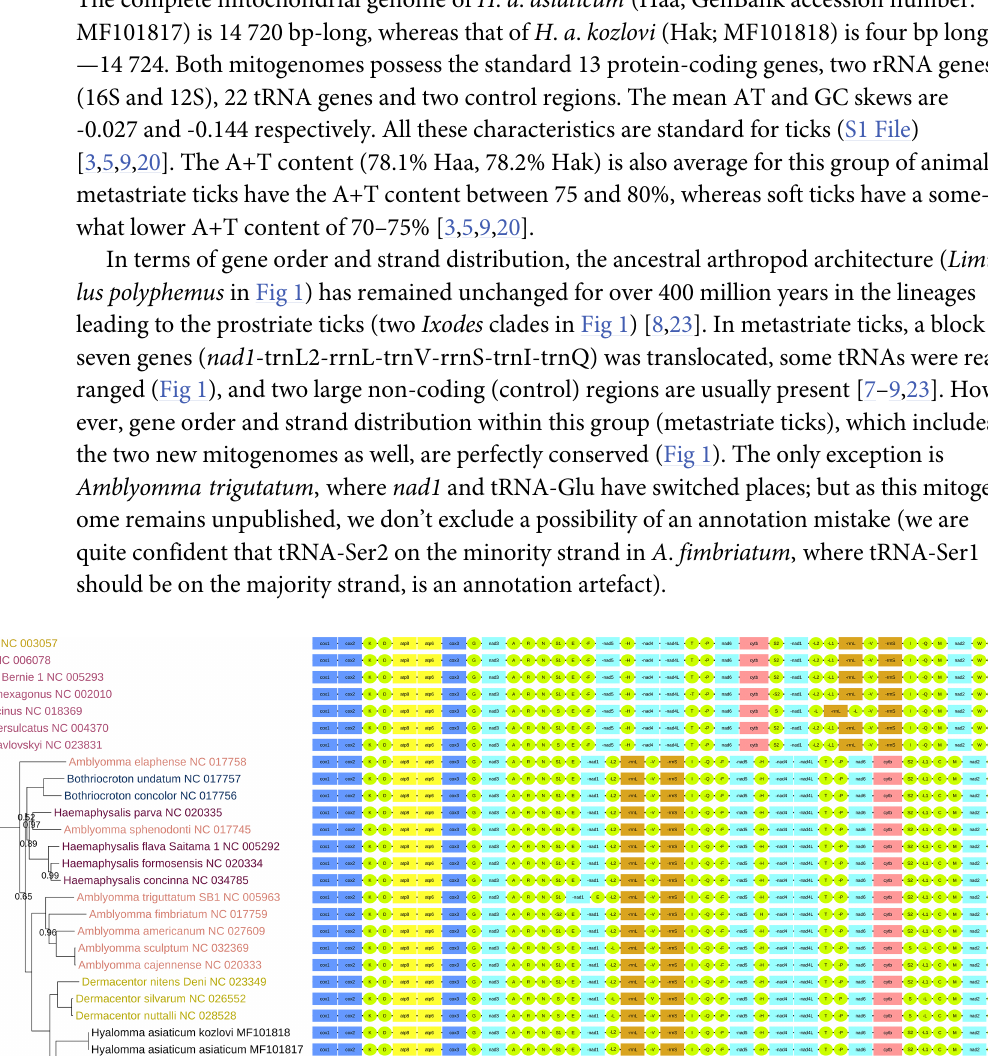
PLOS ONE | https://doi.org/10.1371/journal.pone.0197524 May 16,